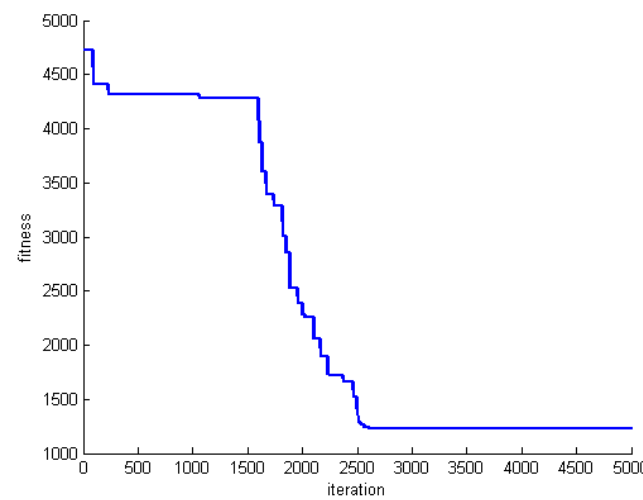
Figure 6. The fitness of the best whale during whales’ motion in 5 D S .